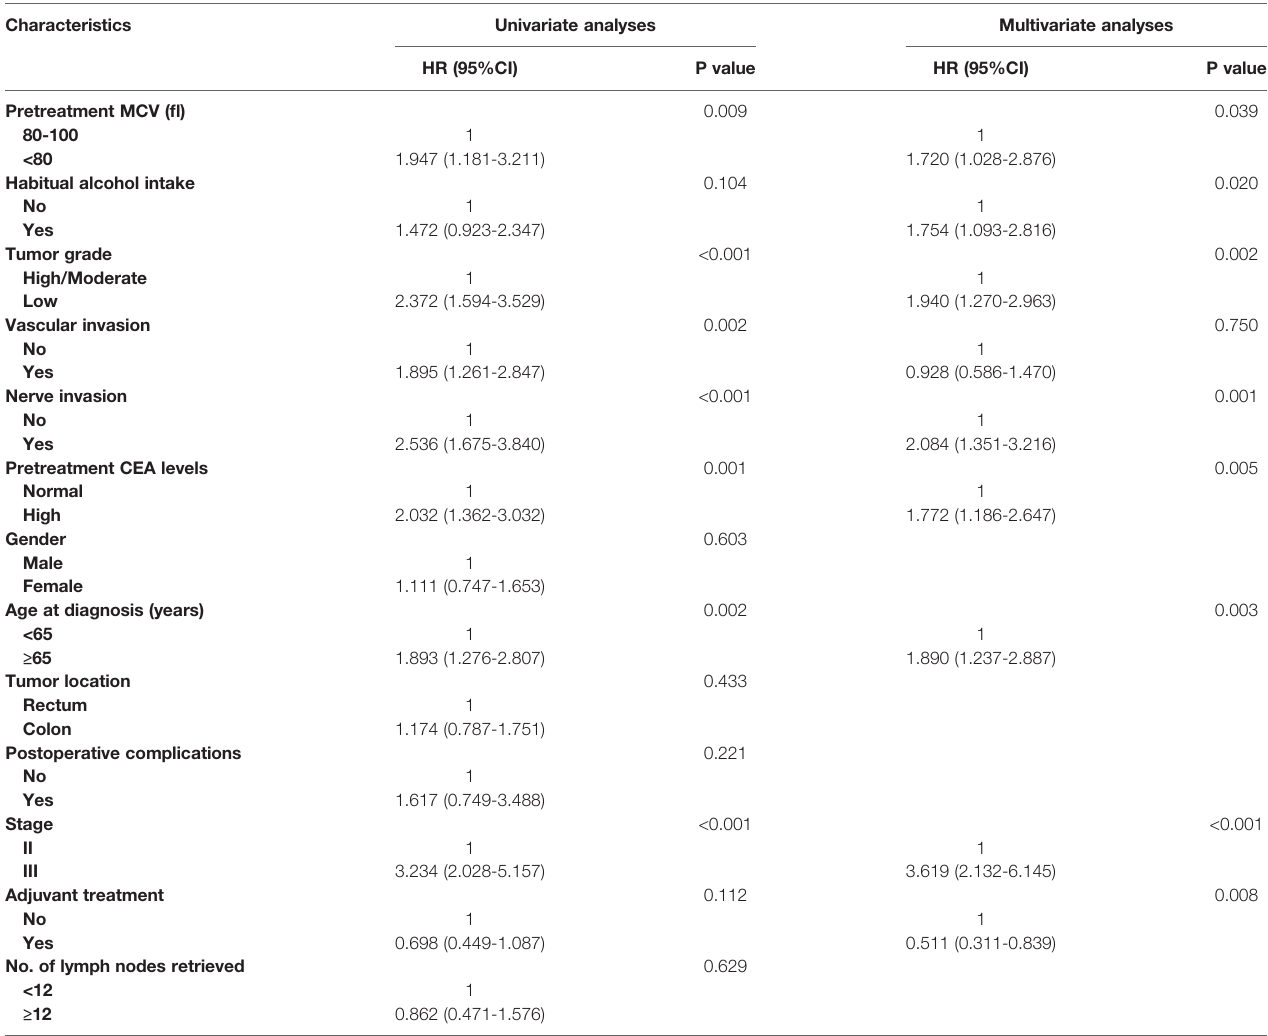
TABLE 2 | Univariate and multivariate Cox regression analyses for OS in the whole cohort.